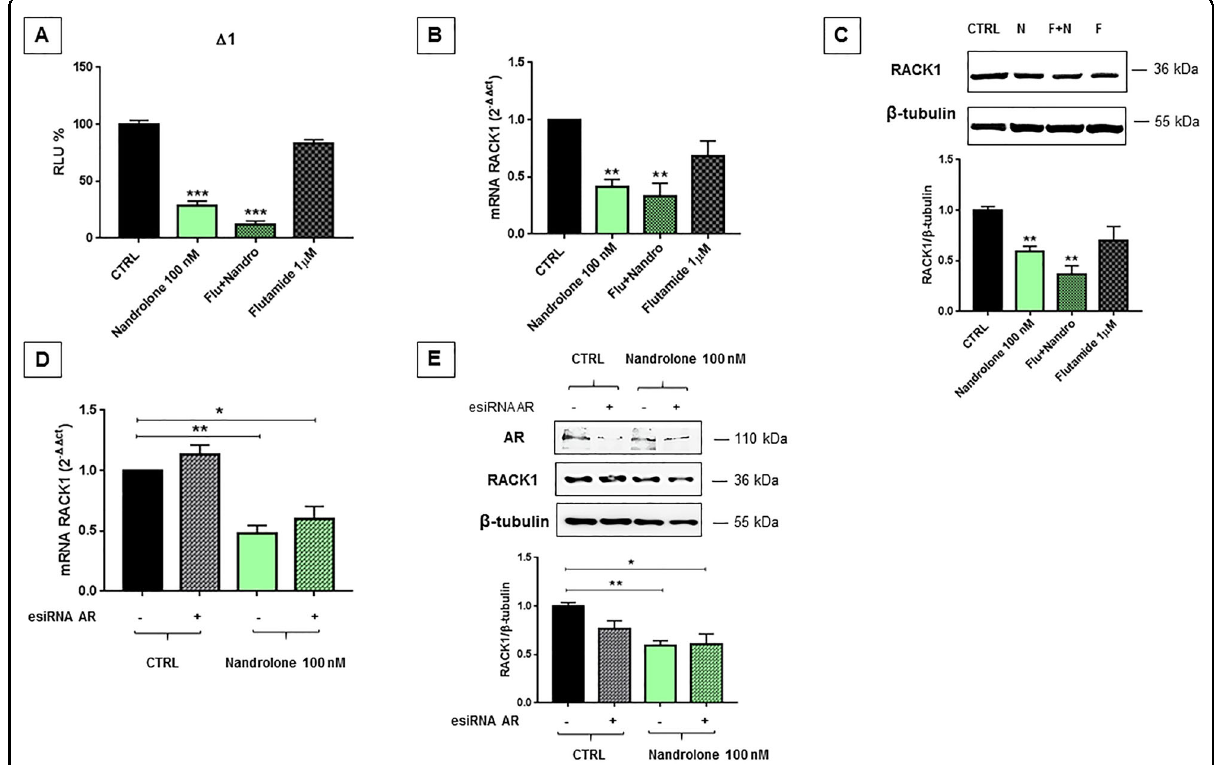
Fig. 1 Nandrolone effect on RACK1 expression. A – E Nandrolone effect on RACK1 expression is AR-independent. A MCF7 cells transfected with Δ 1 were treated for 16 h with 100 nM nandrolone, 1 μ M fl utamide, pretreated for 1 h with 1 μ M fl utamide and subsequently 100 nM nandrolone was added. Vehicle controls were treated with DMSO < 0.1% (CTRL). Luciferase activity was expressed as RLU% and compared to CTRL values assumed at 100%. Each bar represents the mean±SEM of three independent experiments, in quadruplicate. Statistical analysis was performed with Dunnett ’ s test, with *** p < 0.001. B – C MCF7 cells were treated for 16 h or 24 h with 100 nM nandrolone, 1 μ M fl utamide or pretreated for 1 h with 1 μ M fl utamide and subsequently 100 nM nandrolone was added. Vehicle controls were treated with DMSO < 0.1% (CTRL). B RACK1 mRNA expression analysis was performed by real-time PCR. Value bars represent the mean ± SEM of four independent experiments. C RACK1 expression was analyzed by Western Blotting. The image is a representative Western Blot. Results are shown as ratio RACK1/ β -tubulin ± SEM of fi ve independent experiments. B – C Statistical analysis was performed with Dunnett ’ s multiple comparison test, with ** p < 0.01. D – E MCF7 cells were silenced for 48 h with AR